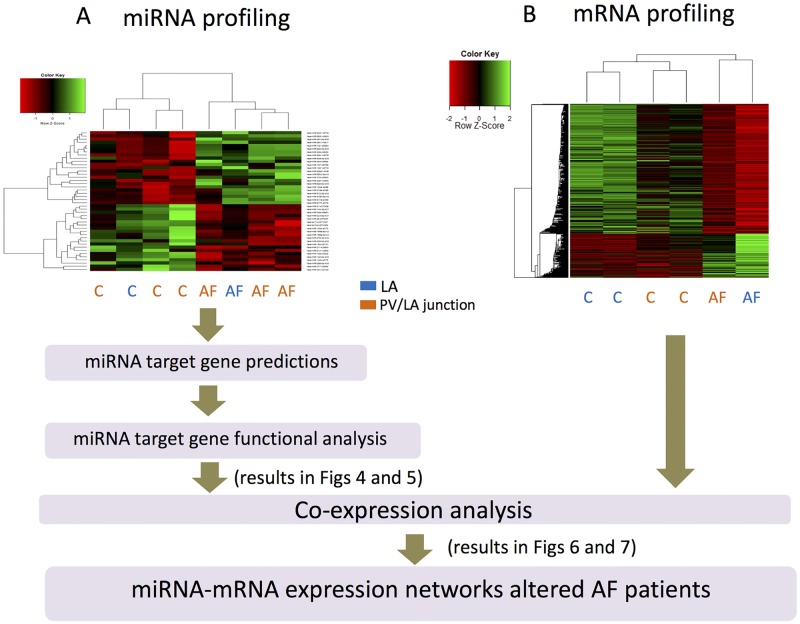
Workflow use to predict the function of the 42 altered miRNAs in left atria (LA) from patient suffering from atrial fibrillation (AF).A) Unsupervised hierarchical clustering and heat-map of the 42 miRNA basal expressions, expressed in patients suffering from valvular heart disease associated with AF or without AF (C = Controls). LA = biopsies from LA; PV/LA = biopsies from pulmonary vein-LA junction. B) mRNA profiling data are from [39] and are available from the Gene Expression Omnibus database GSE31821 (www.ncbi.nlm.nih.gov/gds/).